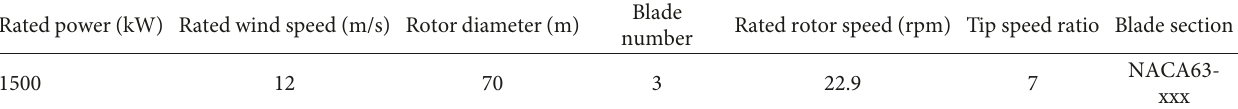
Table 1: Main parameters of the blade.